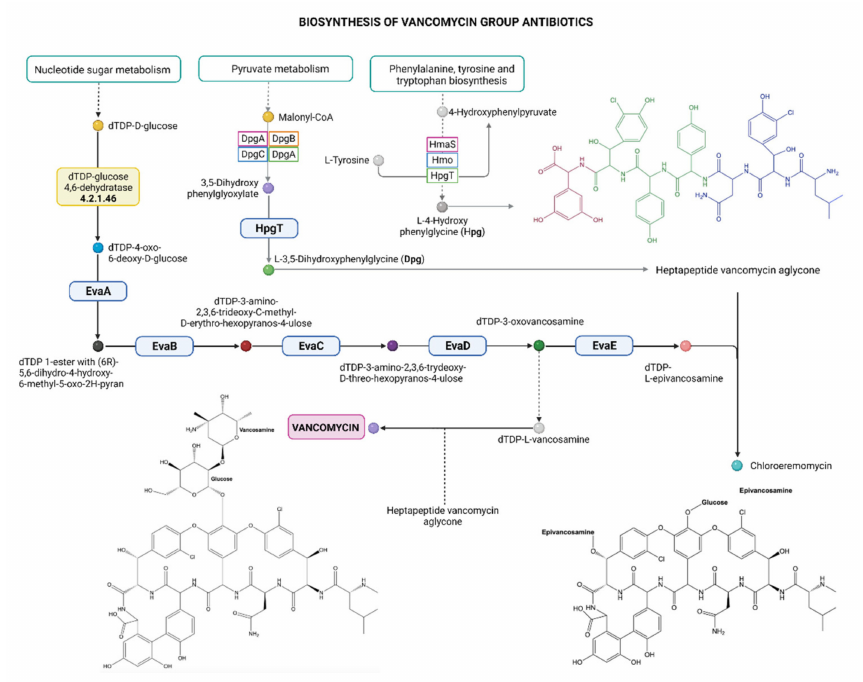
Figure 1. Metabolic pathway responsible for vancomycin biosynthesis. Analysis performed by Patric 3.6.9.